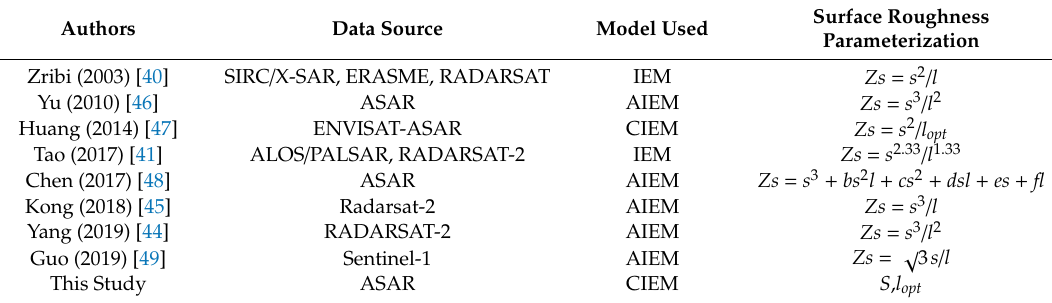
Table 1. Summary of the approaches in related papers.